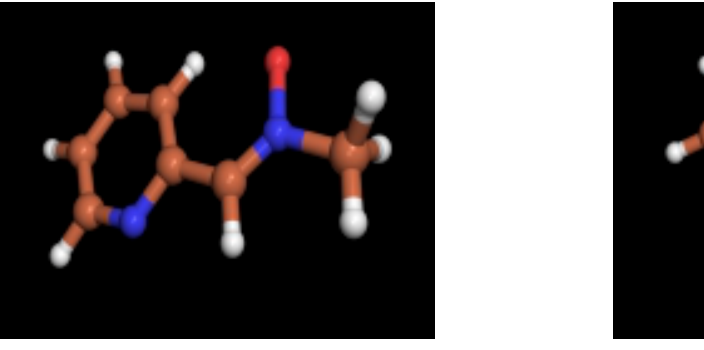
Figure 3. Optimized structure (HF/3-21G) for 2 Figure 4. Optimized structure (HF/3-21G) for 6